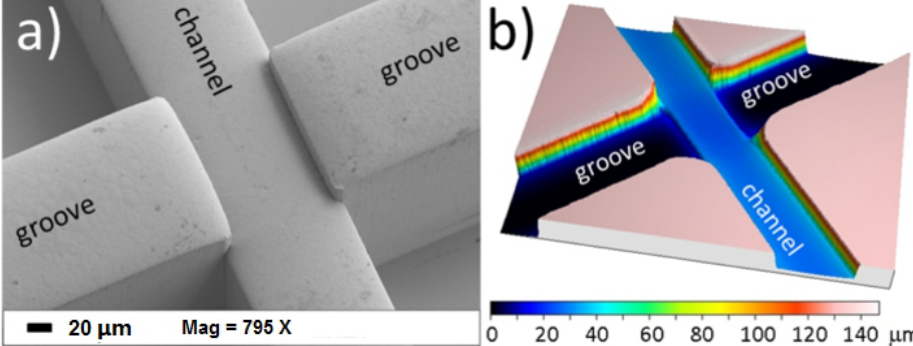
Figure 4. ( a ) SEM microgram of microgrooves for optical fibers. ( b ) confocal microscope profilometry of the microchip that shows the depths of microchannel and microgrooves. Reproduced from [56] from Micromachines published by